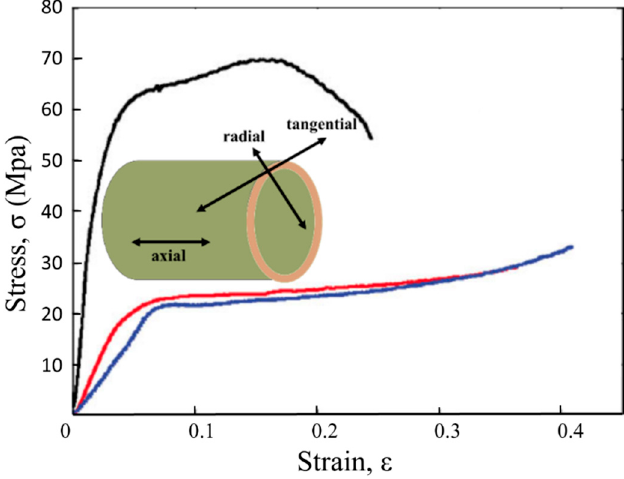
Figure 9. Typical compressive stress-strain curves of bamboo (adapted from [36]).